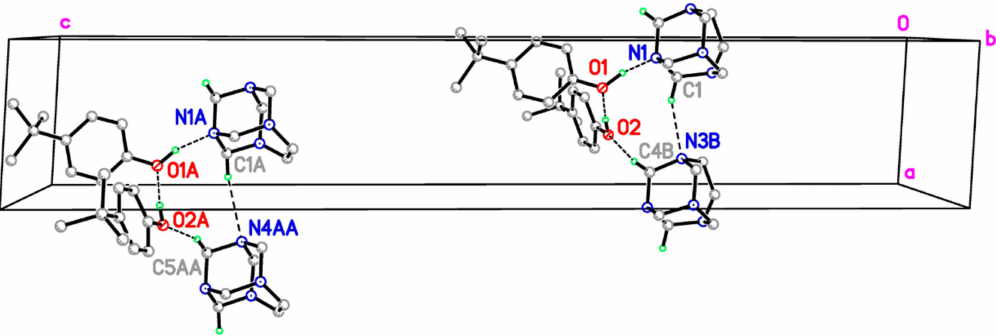
Figure 3. Part of the crystal structure of title compound, showing the formation of ring of graph-set motif R 4 4 (10) and hydrogen bonded columns along [1 0 0]. These are formed by C–H ··· O and C–H ··· N hydrogen-bond interactions. For clarity, H atoms not involved in the motif have been omitted. Green and purple dashed lines indicate the O–H ··· N hydrogen bonds and weak C–H ··· O and C–H ··· N nonconventional hydrogen bonds,